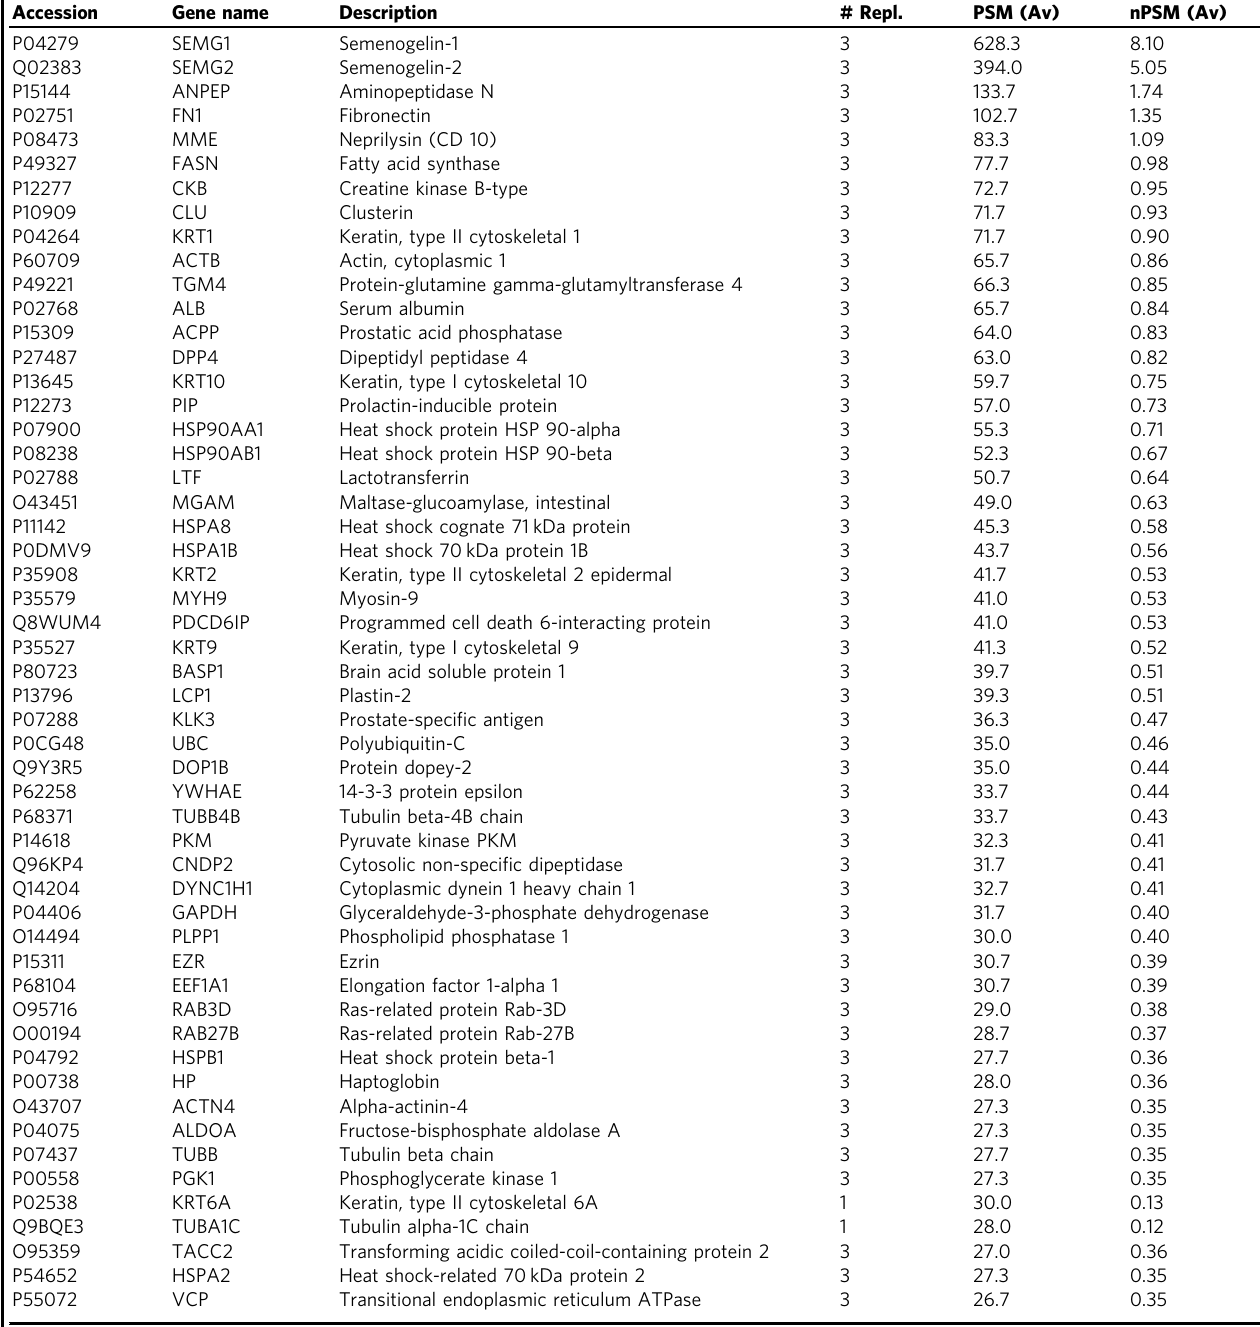
Table 1 Fifty-three proteins found more abundant in the surface fraction from